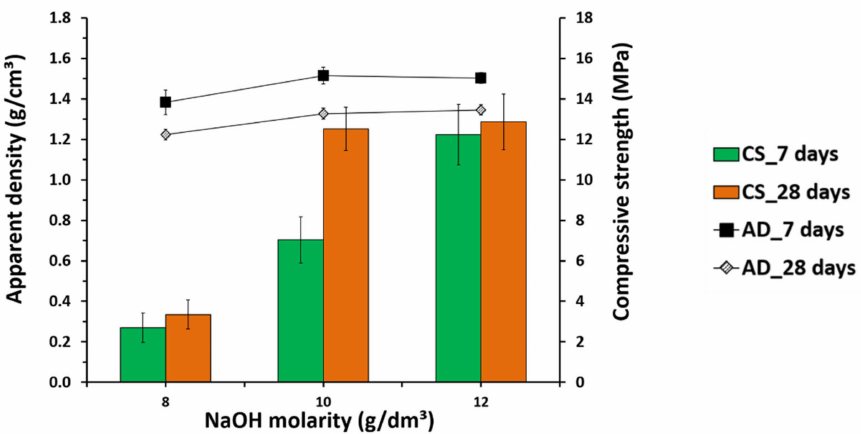
Figure 6. The apparent density and compressive strength of the alkali activated binders at 7 and 28 days of curing as a function of sodium hydroxide